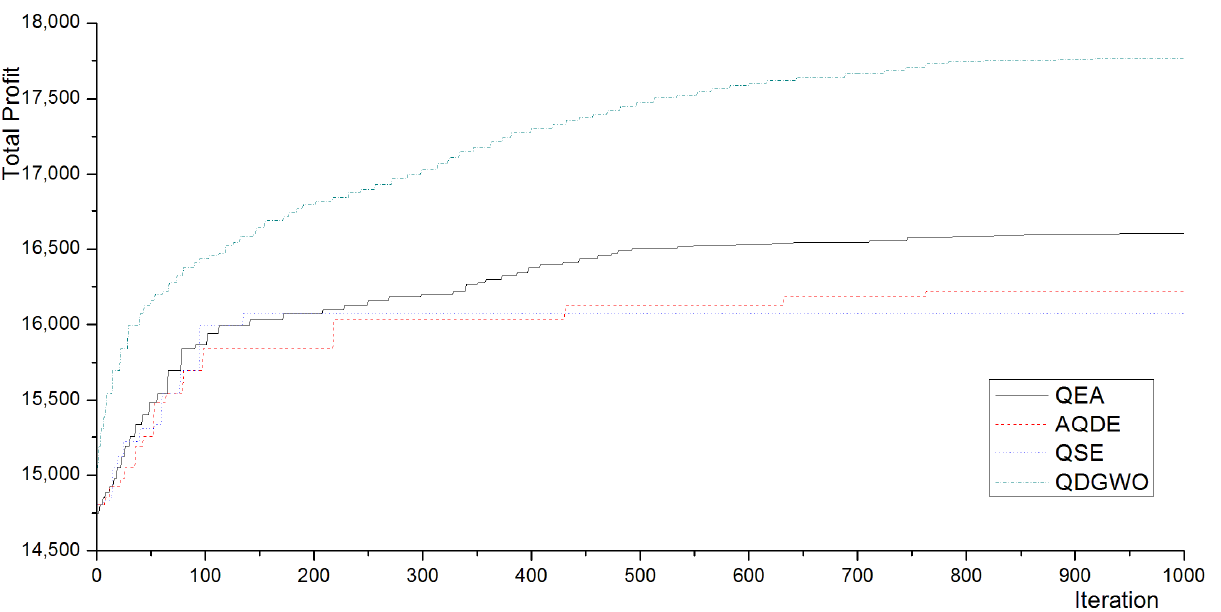
Figure 7. Best profits for the 0-1 knapsack problems (3000 items in Experiment 1).